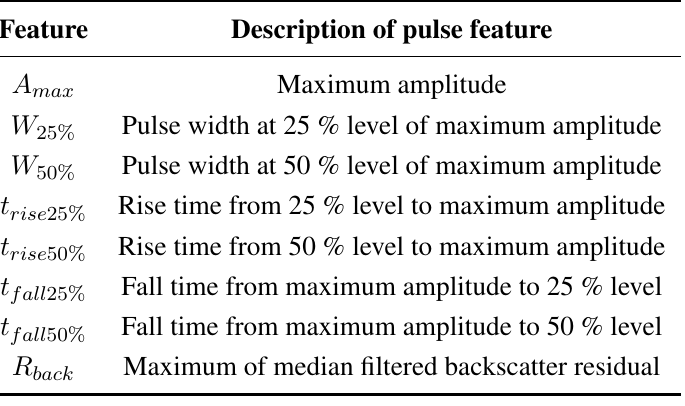
Table 3. List of extracted features from the bottom pulse.